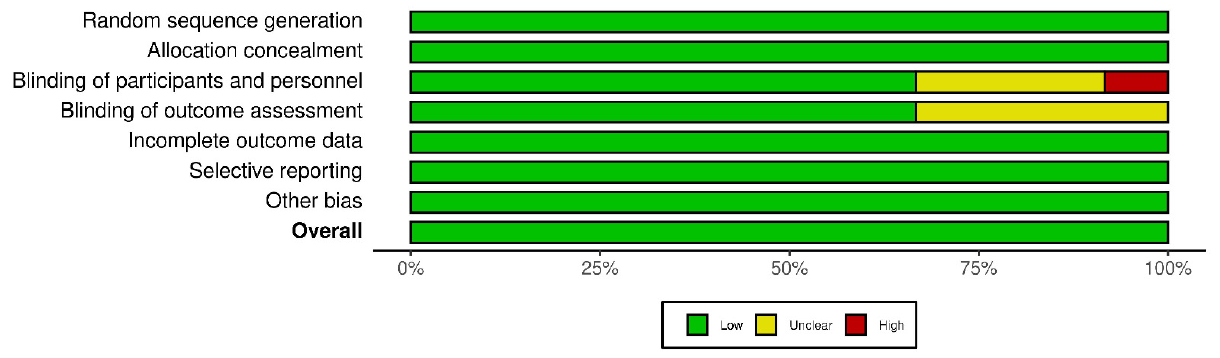
Figure 9. Summary risk of bias.